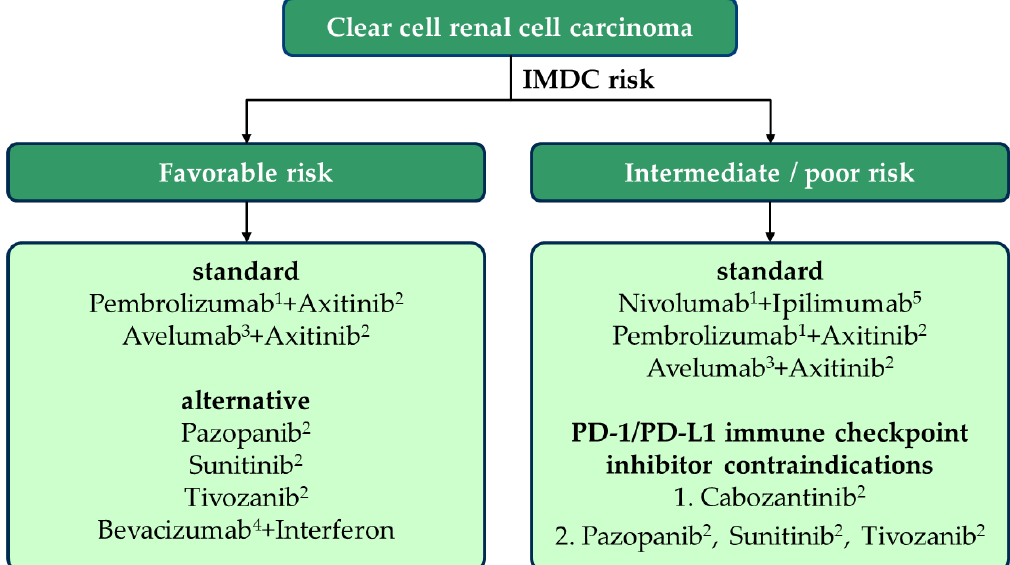
Figure 1. Current therapeutic recommendations for clear cell renal cell cancer; IMDC, International Metastatic Renal Cell Carcinoma Database Consortium. Zero of 6 risk factors (see text): favorable risk, 1–2 of 6 risk factors: intermediate risk, ≥3 of 6 risk factors: poor risk. (1) Anti-PD-1 antibody, (2) VEGFR-TKI, (3) anti-PD-L1 antibody, (4) anti-VEGF antibody, (5) anti-CTLA-4 antibody.